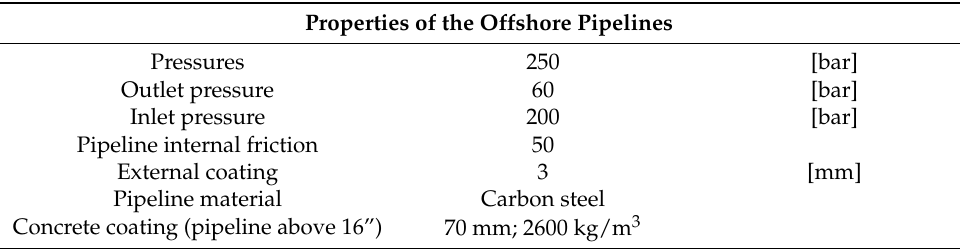
Table 14. Properties of the offshore